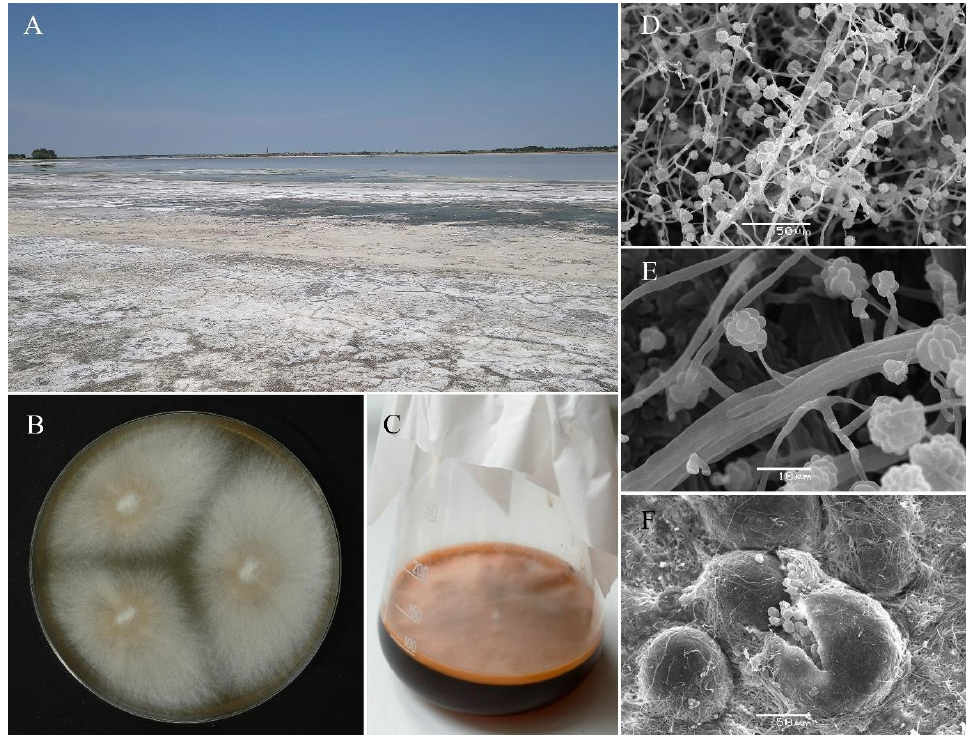
Figure 1. Emericellopsis alkaline in situ and in vitro. ( A ) The edge of the soda lake, typical habitat for E. alkalina (Lake Tanatar-2, Altai area, Russia); ( B ) growth of E. alkalina F-1428 on the alkaline agar medium and ( C ) at the liquid alkaline medium; ( D , E ) E. alkalina conidiophores; and ( F ) fruiting body, SEM.